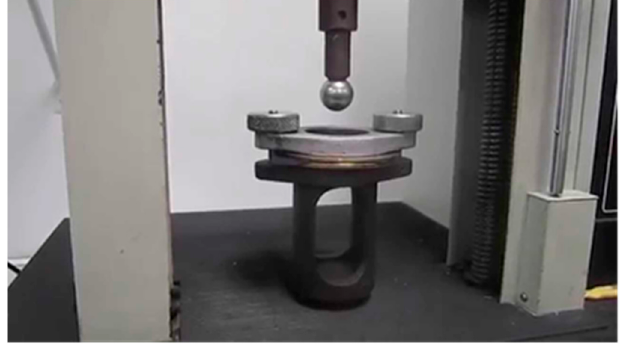
Figure 1. Illustration of the compressive loading of the specimen with a sphere.